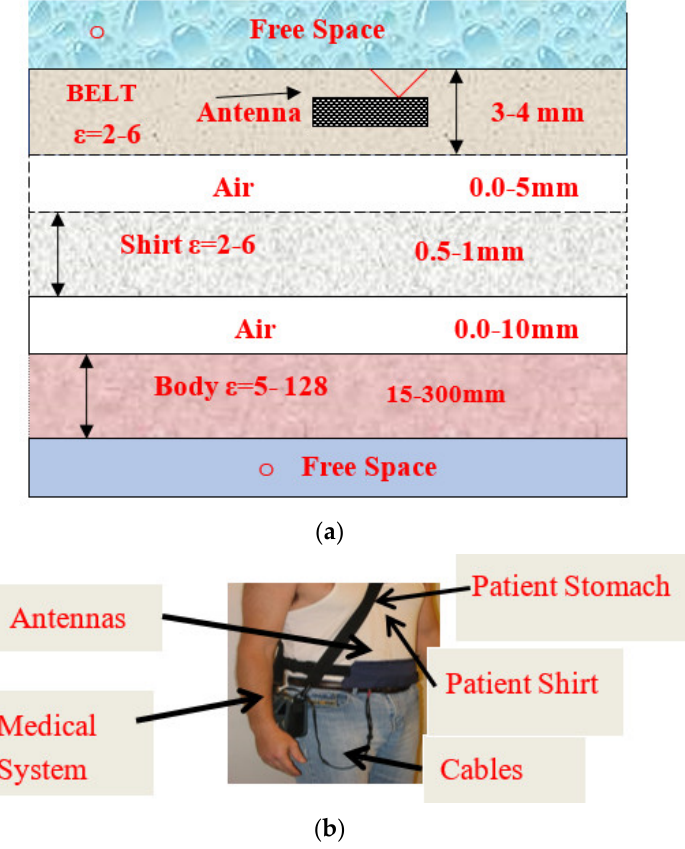
Figure 24. ( a ) Model of human body tissues and antenna ( b ). A patient wearing a wearable healthcare sensor. Table 9. Electrical parameters of human body tissues [16,17].